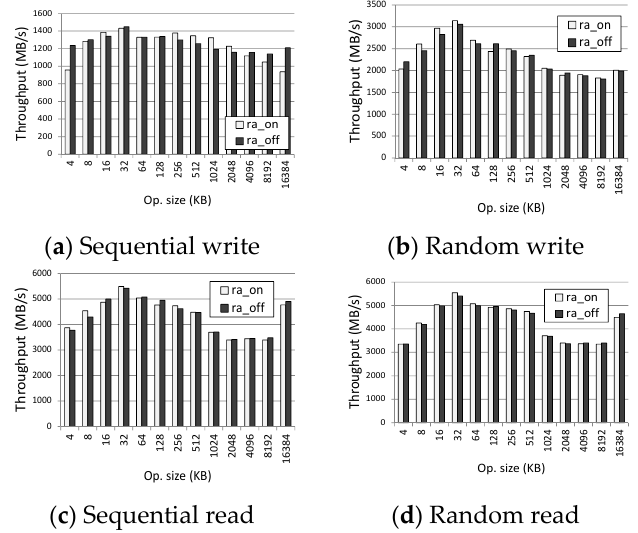
Figure 9. RAMDisk performance when the prefetching option is turned on/off.